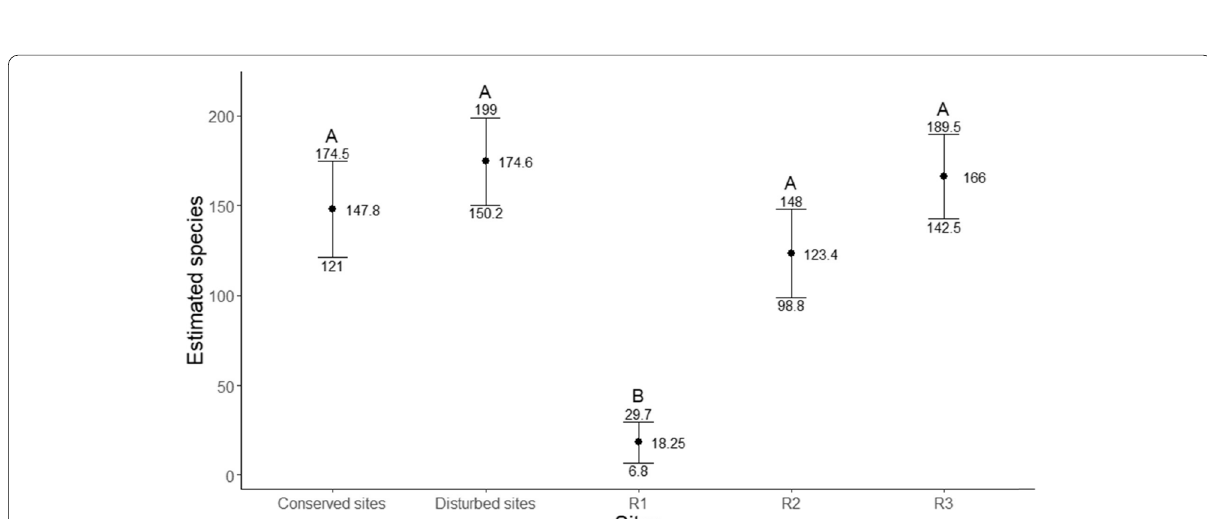
Fig. 3 95% Confidence Intervals of arthropod richness obtained through Chao1 species estimation in conserved, disturbed, and restored sites in the PSAER, based on 857 arthropods in total. Conserved and disturbed sites were grouped to facilitate the interpretation. Lower and upper bar represents minimum, and maximum obtained through a bootstrap resampling with 9999 replicates. The spots represent real richness obtained in our sampling, which is right sided of the bar. Different letters represent different groups due the lack of an overlapped